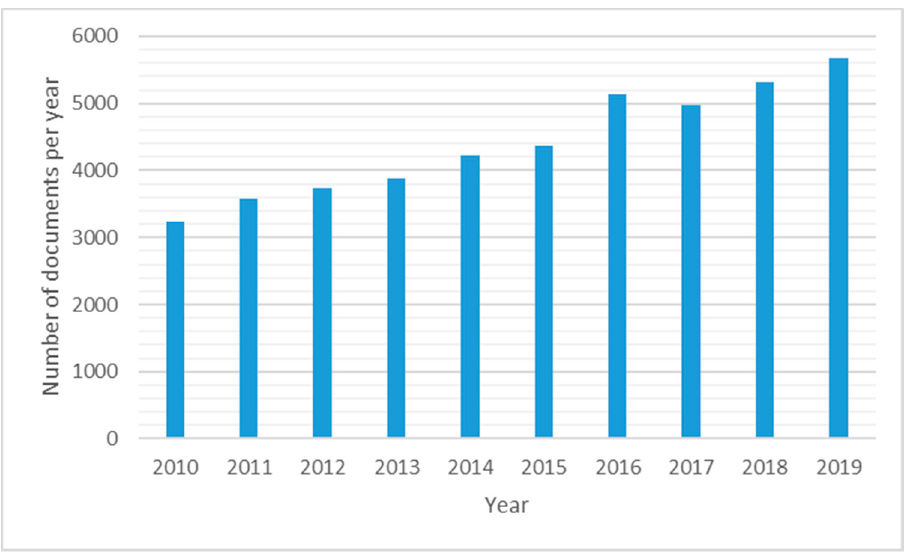
Figure 1. Trend of number of scientific articles on essential oils. Source scopus.com by using ‘essential’ and ‘oil’ as keywords (accessed in February 2020).